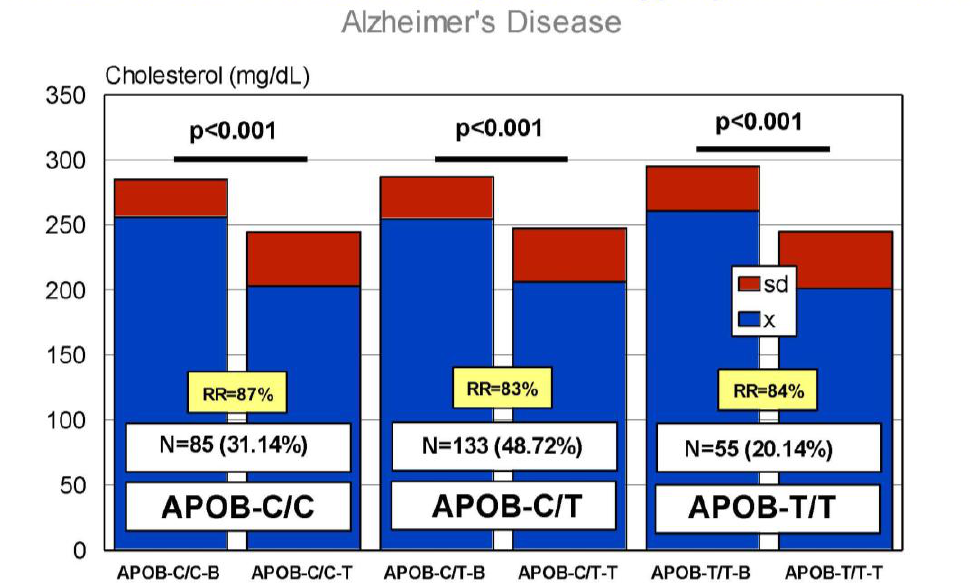
Figure 9. APOB -related cholesterol response to a hypolipemic treatment in hypercholesterolemic patients with Alzheimer’s disease (Atorvastatin: 10–20 mg/day; LipoEsar: 500 mg/day).